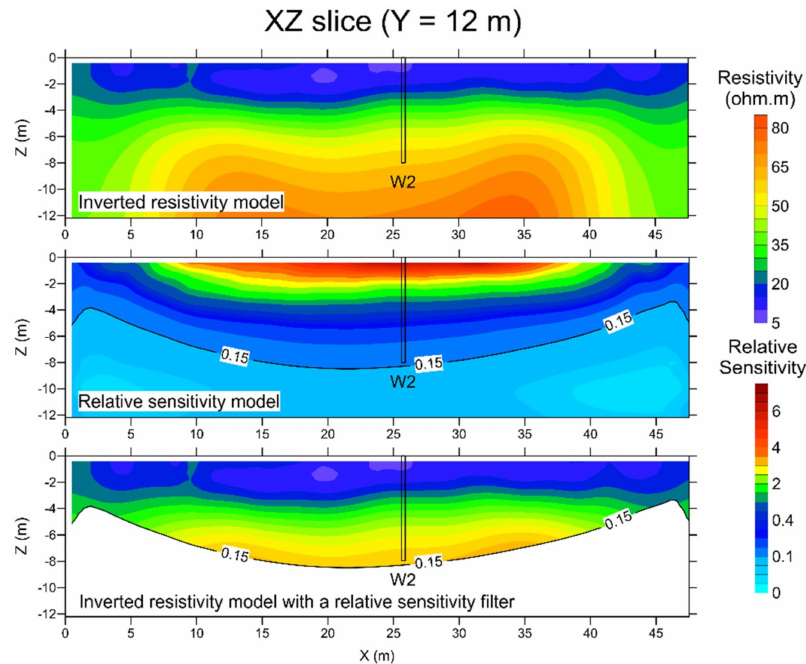
Figure 4. XZ slice (Y = 12 m) of the inverted bulk electrical resistivity model (2nd background) showing the 2 to 3 m tick clay loam layer ( < 20 Ω .m) on top of the alluvial aquifer (60 to 80 Ω .m) (top panel); the associated relative sensitivity model (middle panel) and the application of the relative sensitivity filter on electrical images (bottom panel).